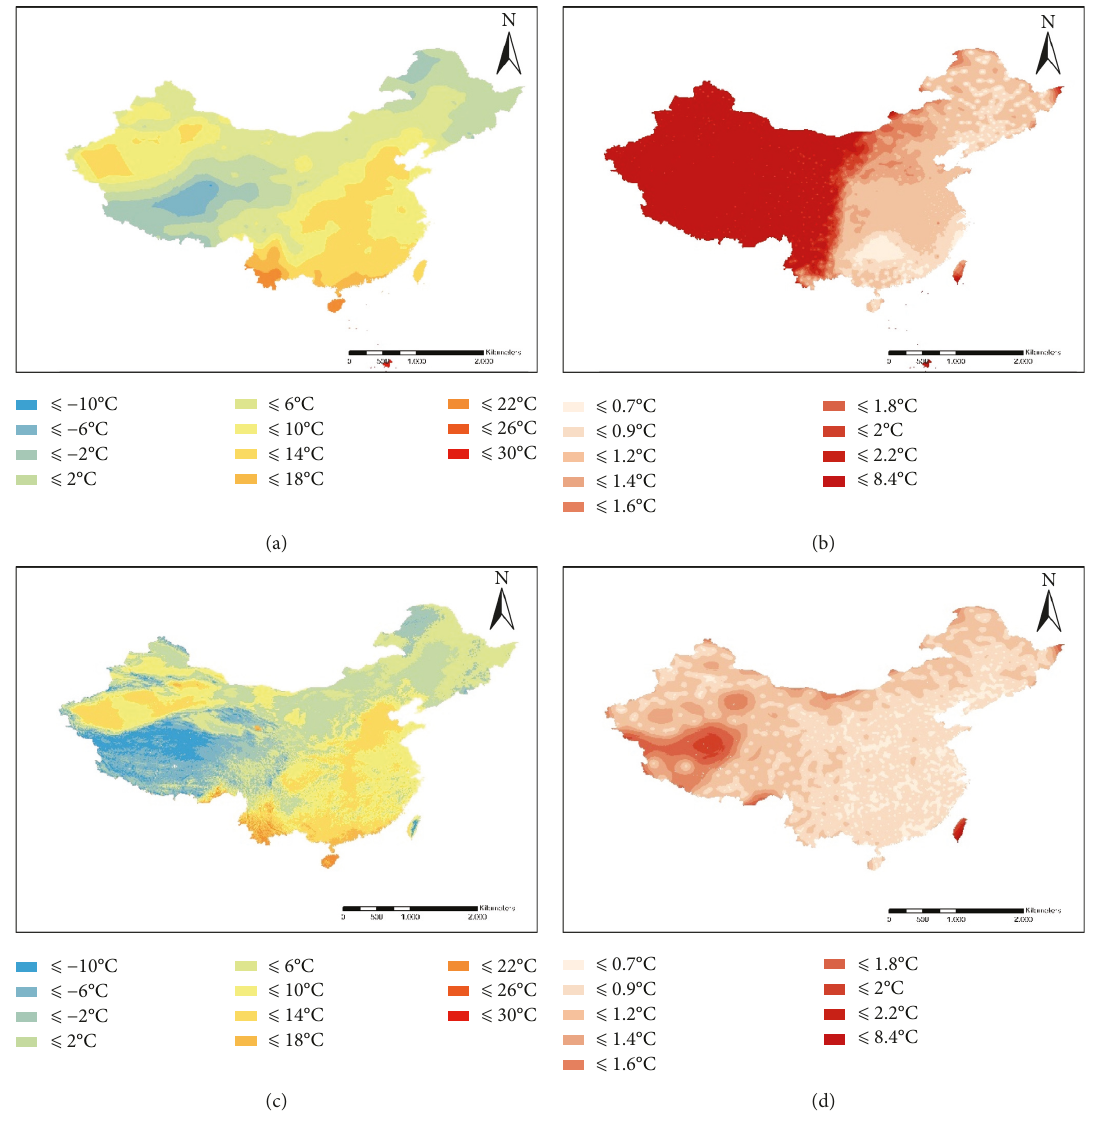
Figure 6: VE interpolation maps of T a -mean with (a) BME-hard and (c) BME-both. (b, d) The corresponding prediction standard error